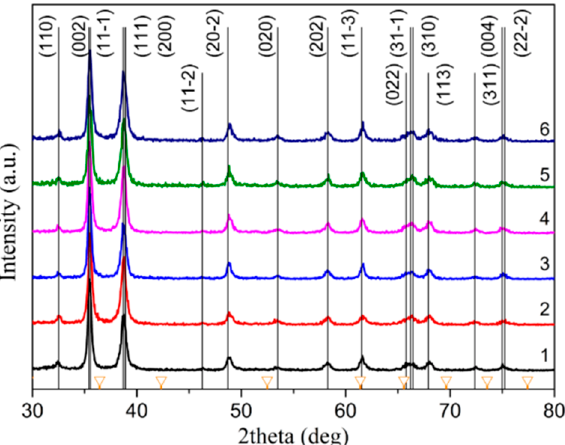
Figure 1. XRD patterns from synthesized CuO films at different substrate temperatures T s , K: (1) 600, (2) 625, (3) 650, (4) 675, (5) 700, and (6) 725. (Black vertical lines correspond to CuO; orange lines